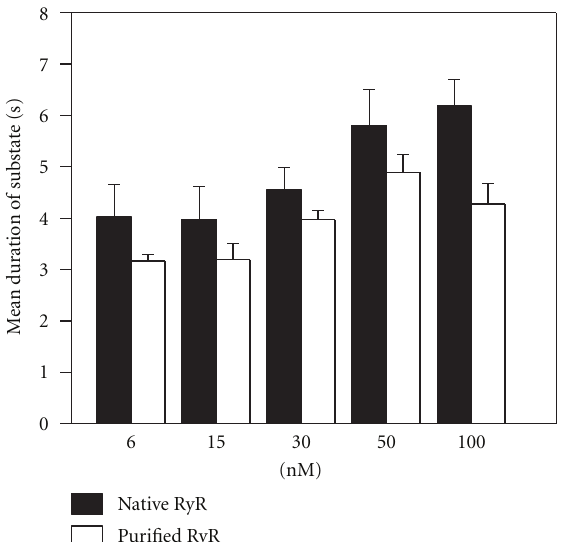
Figure 4: E ff ects of IpTx a on the mean durations of substate of native and purified RyR1. Mean durations of the substate events in native RyR1 versus purified RyR1 were determined in the presence of 6–100 nM IpTx a . Data points are means ± SE for 10 experiments.